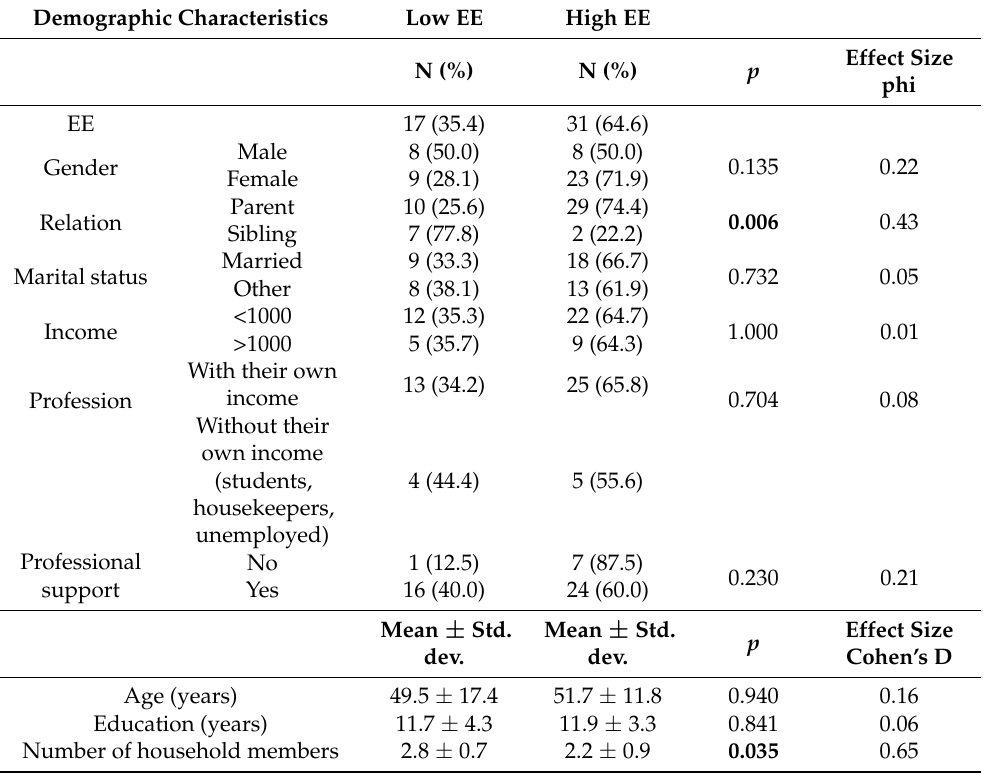
Table 1. Demographic characteristics of the relatives based on their level of expressed emotion (EE) towards the patient (N =